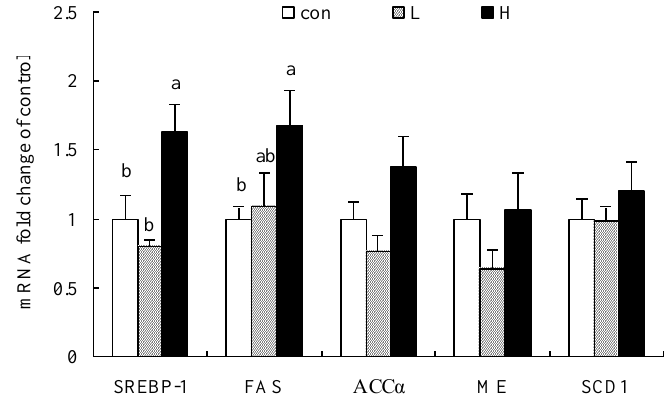
Figure 1. Effects of Kp-10 on the hepatic expression of lipogenic genes including SREBP-1, FAS, ACC  , ME and SCD1 mRNA in quails. Values are means  SE of fifteen replications. The data points without same superscripts (a, b) are significantly different (one-way ANOVA) at the level of p<0.05 by least square difference tests.